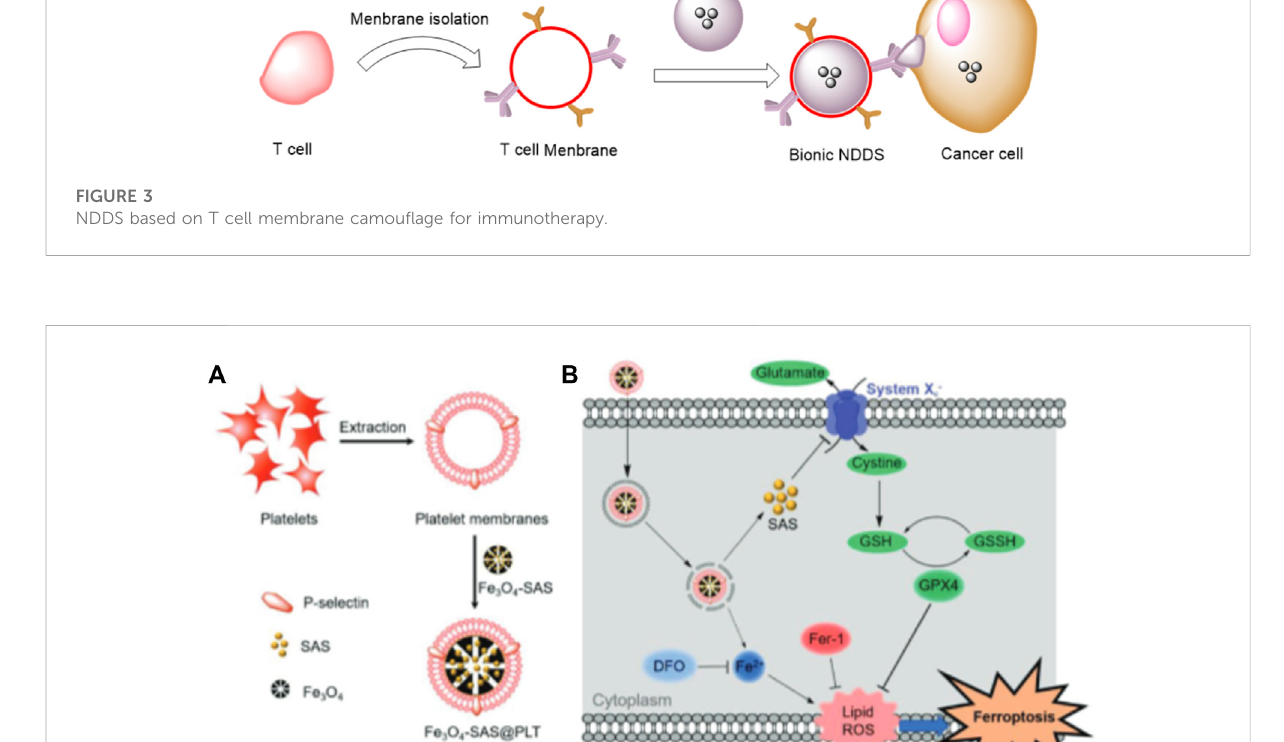
Frontiers in Bioengineering and